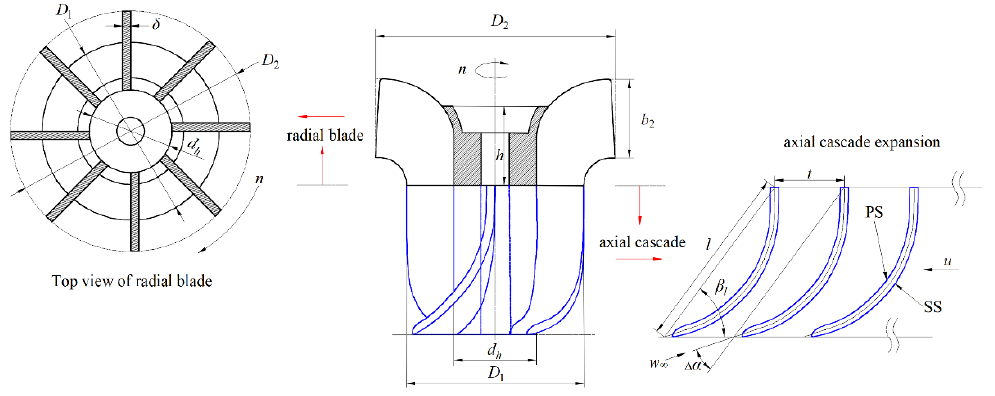
Figure 2. Geometry parameters of the compound impeller.